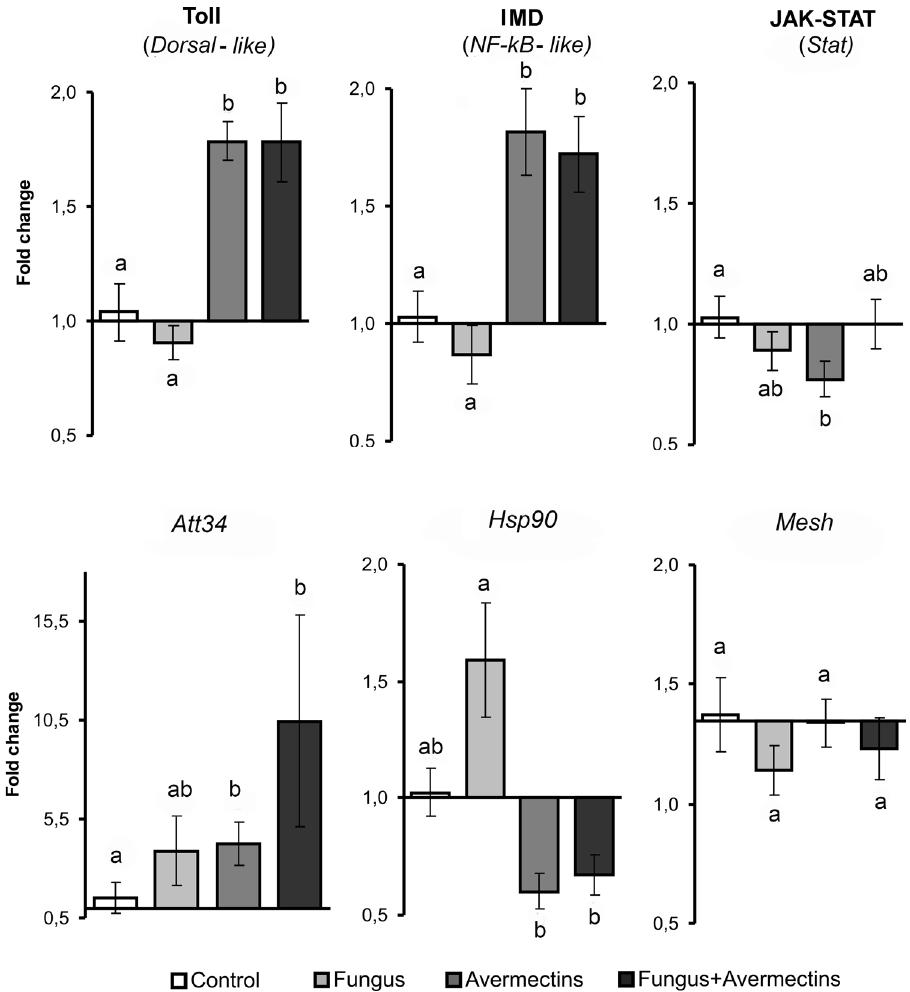
Figure 5. Alterations in the expression of transcriptional factors of Toll, IMD and JAK-STAT immune- signaling pathways, antimicrobial peptide attacin 34 ( Att34 ), heat-shock protein ( Hsp 90) and DUOX regulator ( Mesh ) in the midgut of Colorado potato beetle larvae at 48 h after topical treatment with M. robertsii conidia, oral administration of avermectins and the combined treatment. Data were normalized based on the expression of two reference genes, Rp4 and Arf19 . Different letters indicate significant differences between treatments (Dunn’s test, P <